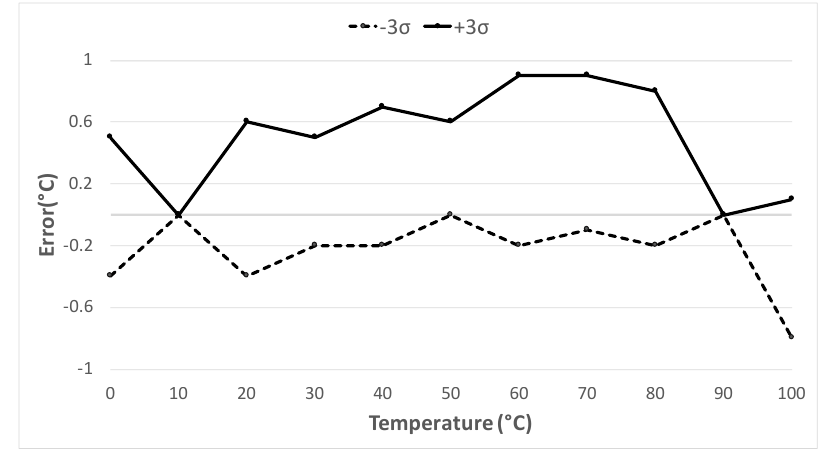
Figure 9. Monte Carlo boundaries (+3 σ and − 3 σ ).